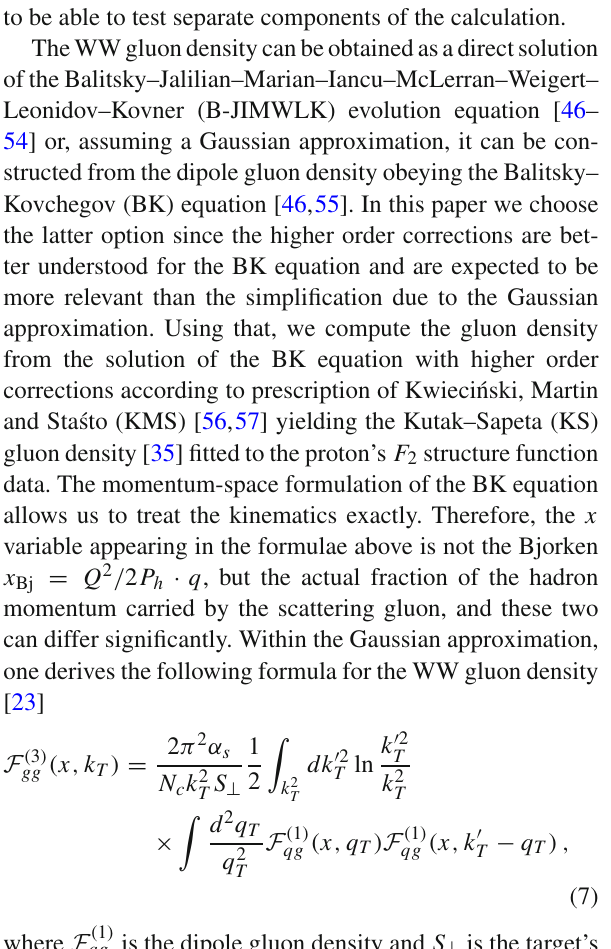
jet1 o n d r h a